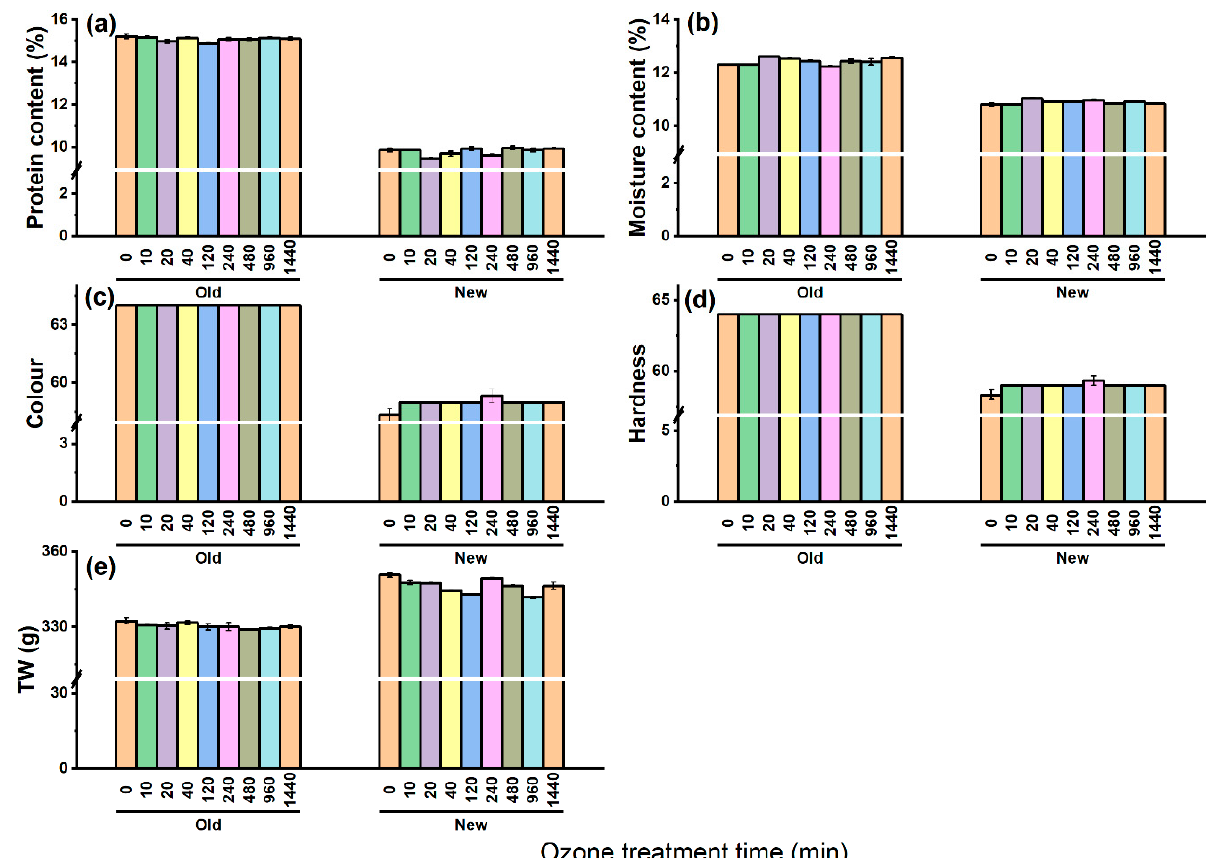
Figure 3. Effect of O 3 duration on the quality of barley seeds. ( a ) The protein content; ( b ) moisture content; ( c ) colour; ( d ) hardness; ( e ) thousand seeds weight. There is no significant differences between each ozonetreatments based on Tukey’s HSD test.